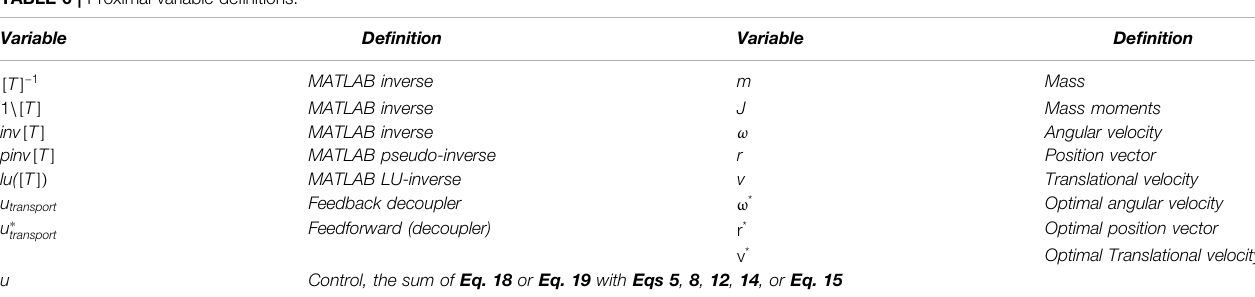
TABLE 6 | Proximal variable de fi nitions.